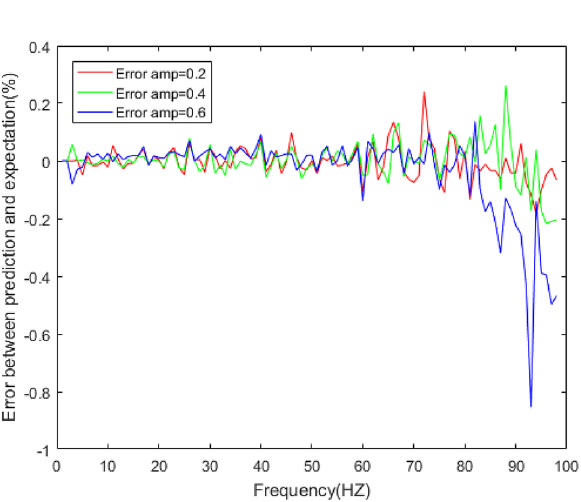
Figure 15. Errors between the prediction results and experimental results of dynamic stiffness under different